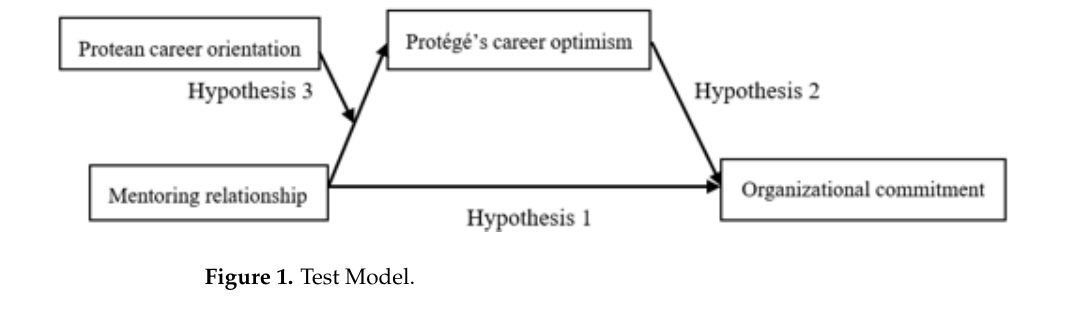
Figure 1. Test Model.